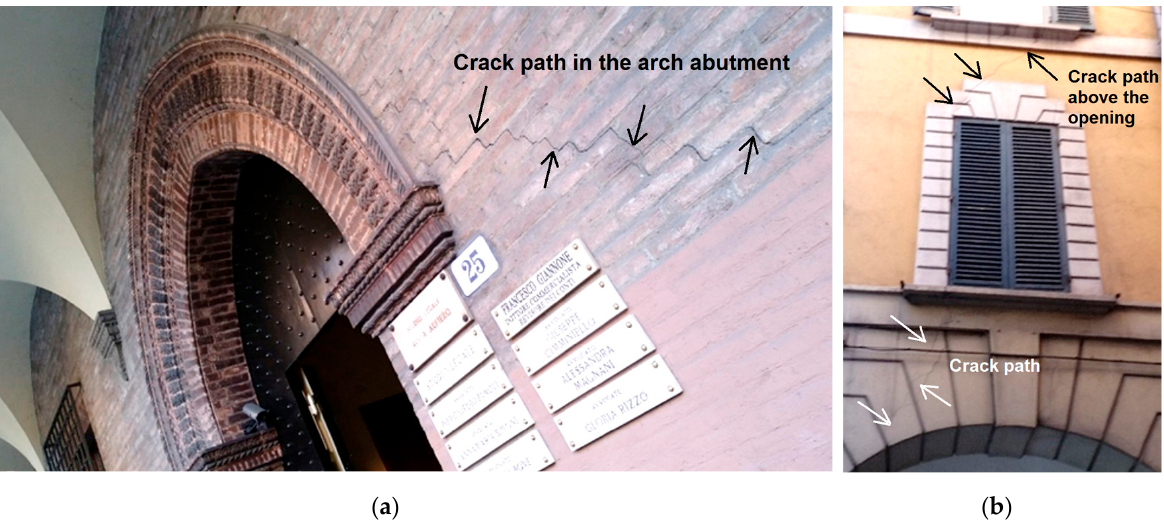
Figure 10. ( a ) Crack path in the arch abutment due to thrust pressure; ( b ) crack near window open- ings, Bologna, Italy. openings, Bologna,